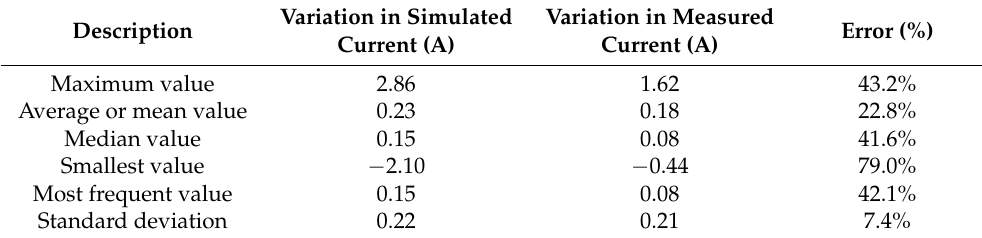
( b ) Figure 37. Physical path and real mobile robot. ( a ) Close view. ( b ) Mobile robot on the path.